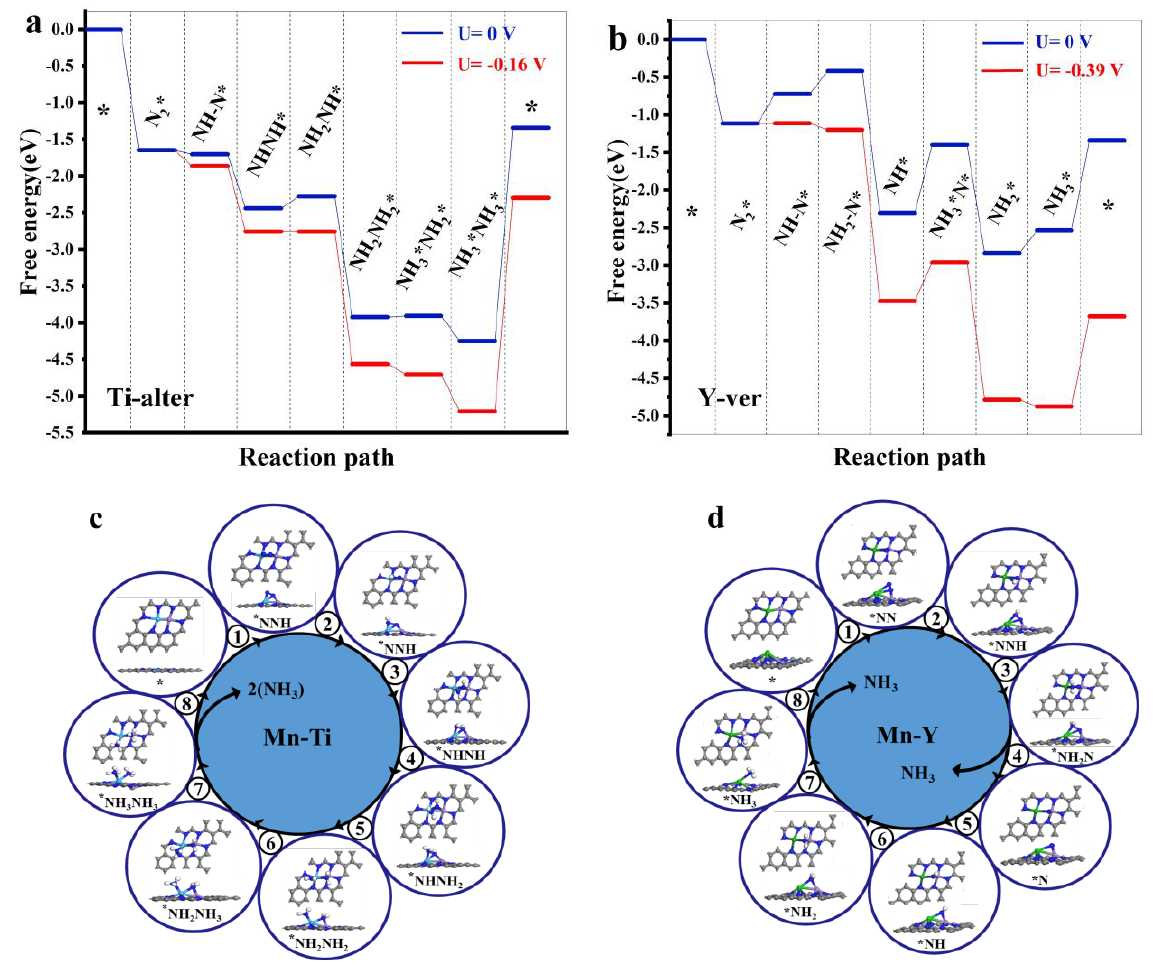
Figure 4. ( a ) The NRR free energy reaction path diagram of Ti-Mn@N 6 -C; ( b ) NRR free energy reaction path diagram of Y-Mn@N 6 -C; ( c ) Reflects the optimized top and side views on Ti-Mn@N 6 -C; ( d ) Reflects the optimized top and side views on Y-Mn@N 6 -C.